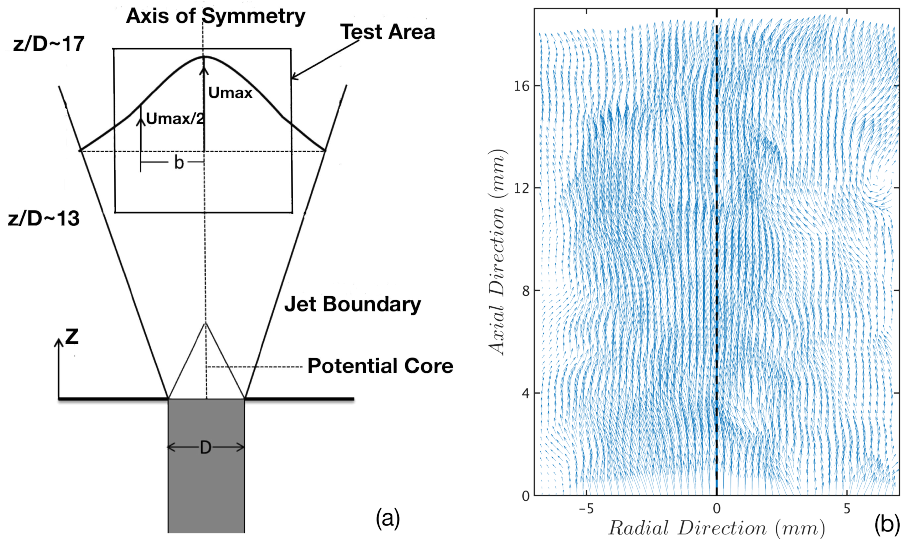
Figure 9. ( a ) Axisymmetric jet flow is generated by N 2 gas ejected from cylinder of radius D = 4.7 mm. Rectangular region of size 13.4 mm × 17.7 mm where velocity measurements were made is approxi- mately 13 D downstream of inlet. ( b ) Snapshot of velocity field for flow of Re ≈ 21,000.